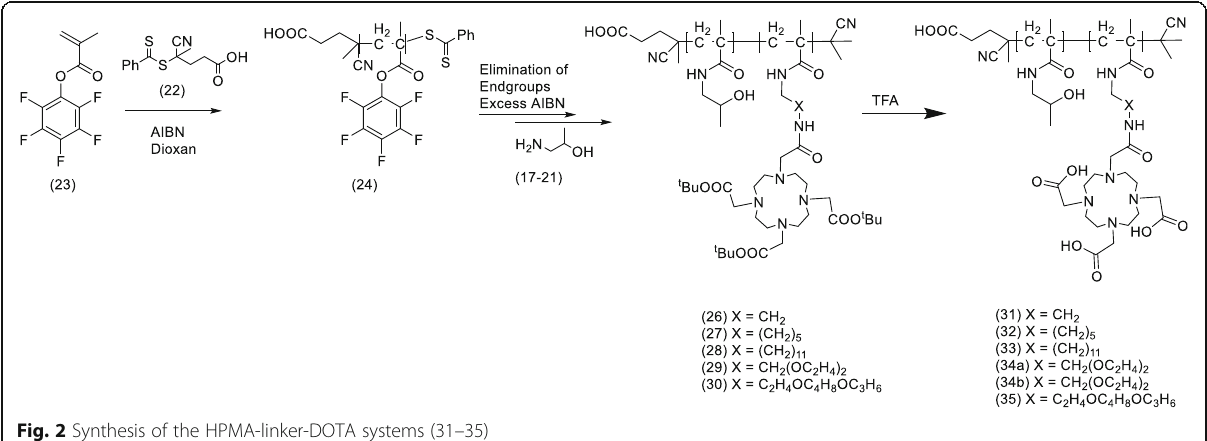
Fig. 2 Synthesis of the HPMA-linker-DOTA systems (31 –